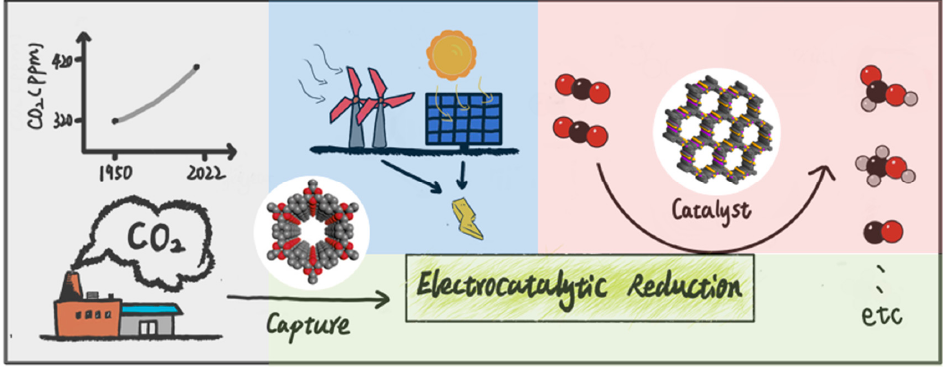
Scheme 1. Porous materials for CO 2 capture and electrocatalytic